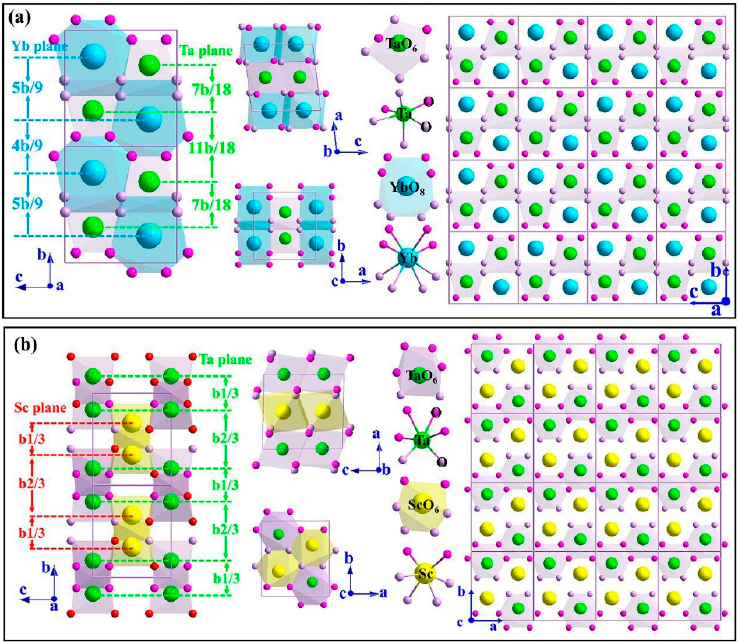
Figure 36. Characteristics of crystal structures in m’ phase RETaO 4 (RE = Yb, Lu, Sc) ceramics: ( a ) YbTaO 4 ( b ) ScTaO 4 [193].